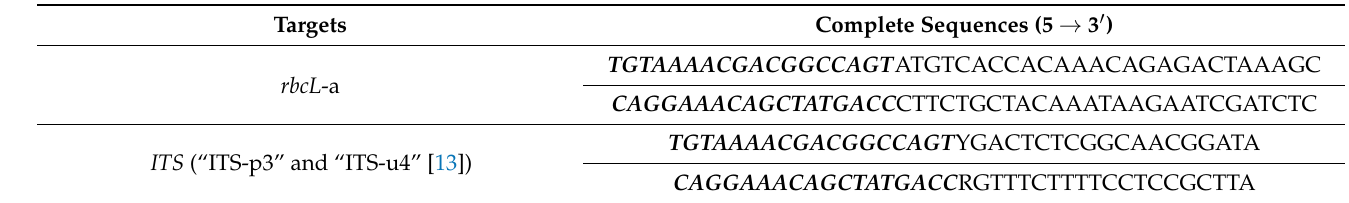
Table 6. Complete primer sequences for the DNA-based identification of field horsetail ( Equisetum arvense ). Each sequence is a chimera of the target-specific primer sequence, connected to a M13 tail at its 5 (cid:48) end. In this table, M13 tails are bolded and italicized.